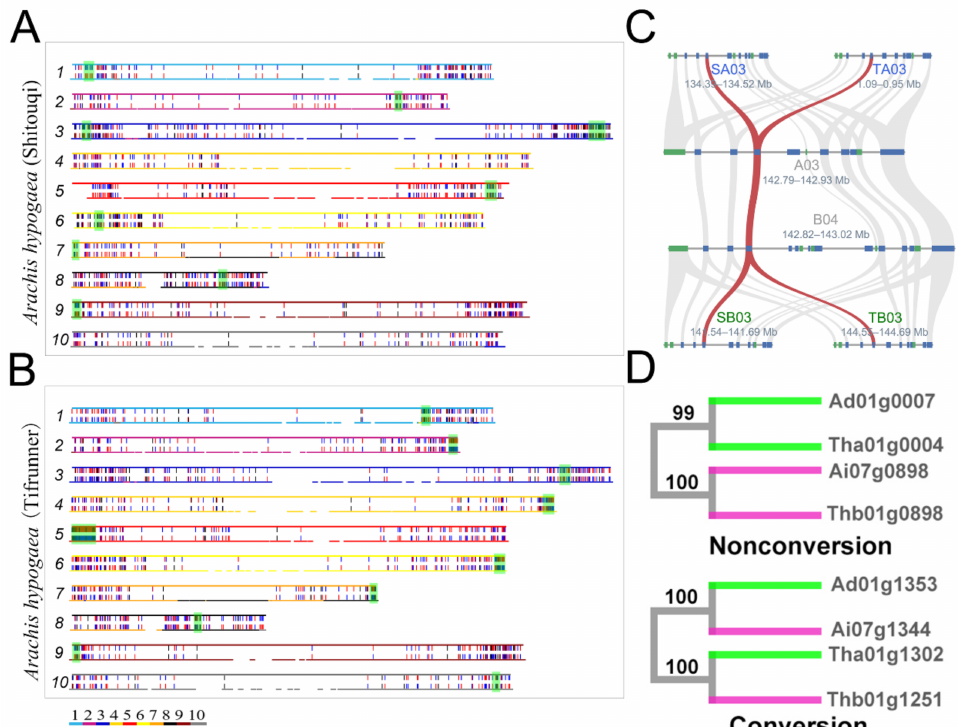
Figure 4. Gene conversions between PRT-related duplicated genes in two cultivated tetraploid peanuts genomes. ( A ) Twenty chromosomes of Shitouqi are divided into ten groups according to the corresponding relationship of the subgenomes in Shitouqi. Converted duplicated genes related to PRT are marked out with a short line according to their location on subgenome A and B, while the red lines indicate genes from converted duplicates as donors and the blue lines indicate acceptor genes; the highlighted region indicates that the number of converted genes is no less than 25% of duplicates in the region. ( B ) Gene conversions between PRT-related duplicated genes in Tifrunner genome. ( C ) Colinearity and conversion at the end of chromosome 3 in Shitouqi and Tifrunner; rectangles represent annotated genes with orientation on the same strand (blue) or reverse strand (green); the grey lines connect syntenic gene pairs and red lines connect conversion genes. ( D ) The top is the tree of nonconverted genes and the bottom is the converted gene